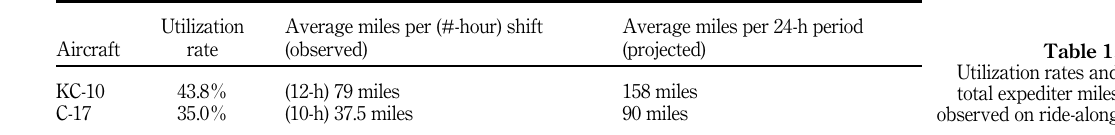
Table 1. Utilization rates and total expediter miles observed on